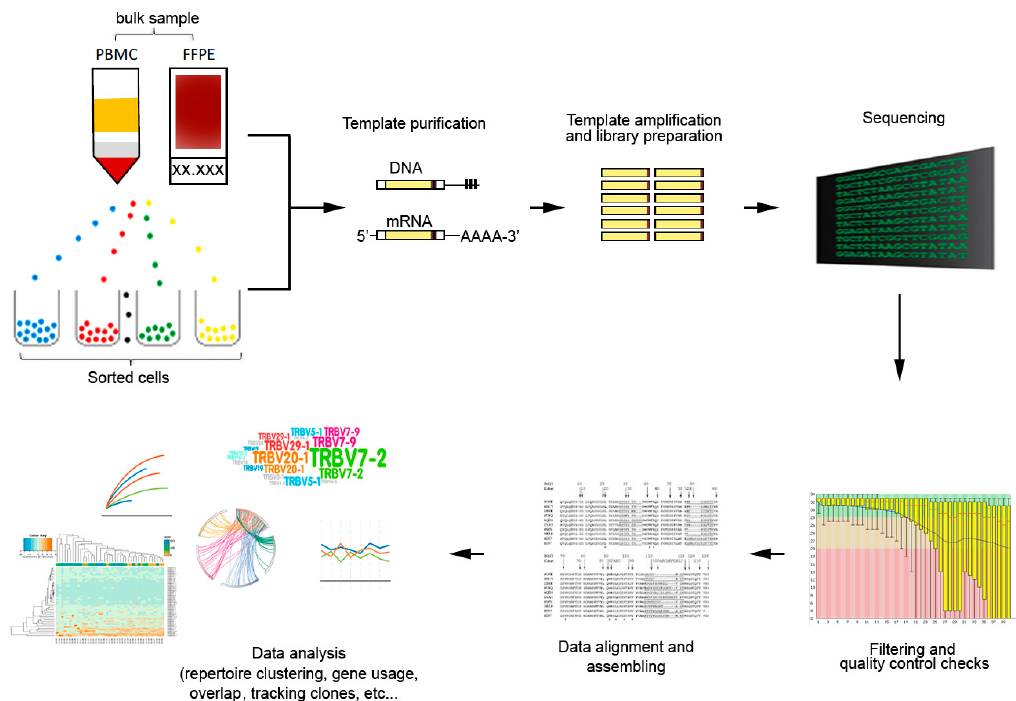
Figure 3. General workflow for TCR repertoire sequencing and analysis. From bulk samples (tissues or peripheral blood) or sorted cells, genomic DNA of mRNA templates are isolated and amplified by polymerase chain reaction (PCR) with specific primers to generate to generate the TCR library. High-throughput sequencing generate the TCR sequencing data that can be analyzed with bioinformatics tools based on different research objectives.